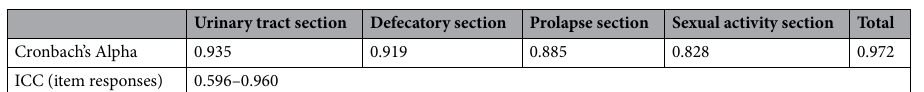
Table 3. Reliability and Response to the item (ICC) of the